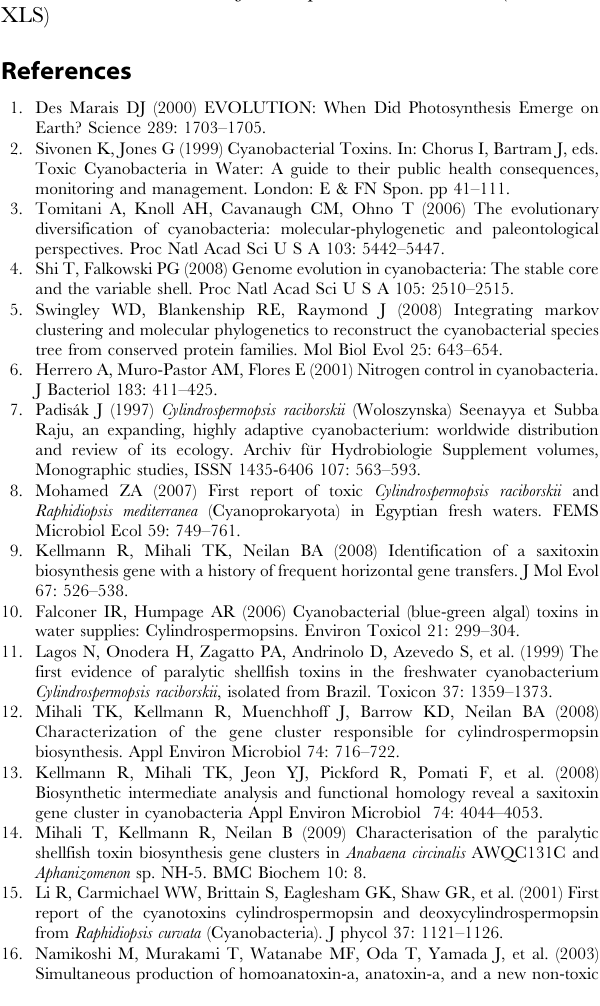
Table S3 Genes common to all heterocystous cyanobacteria